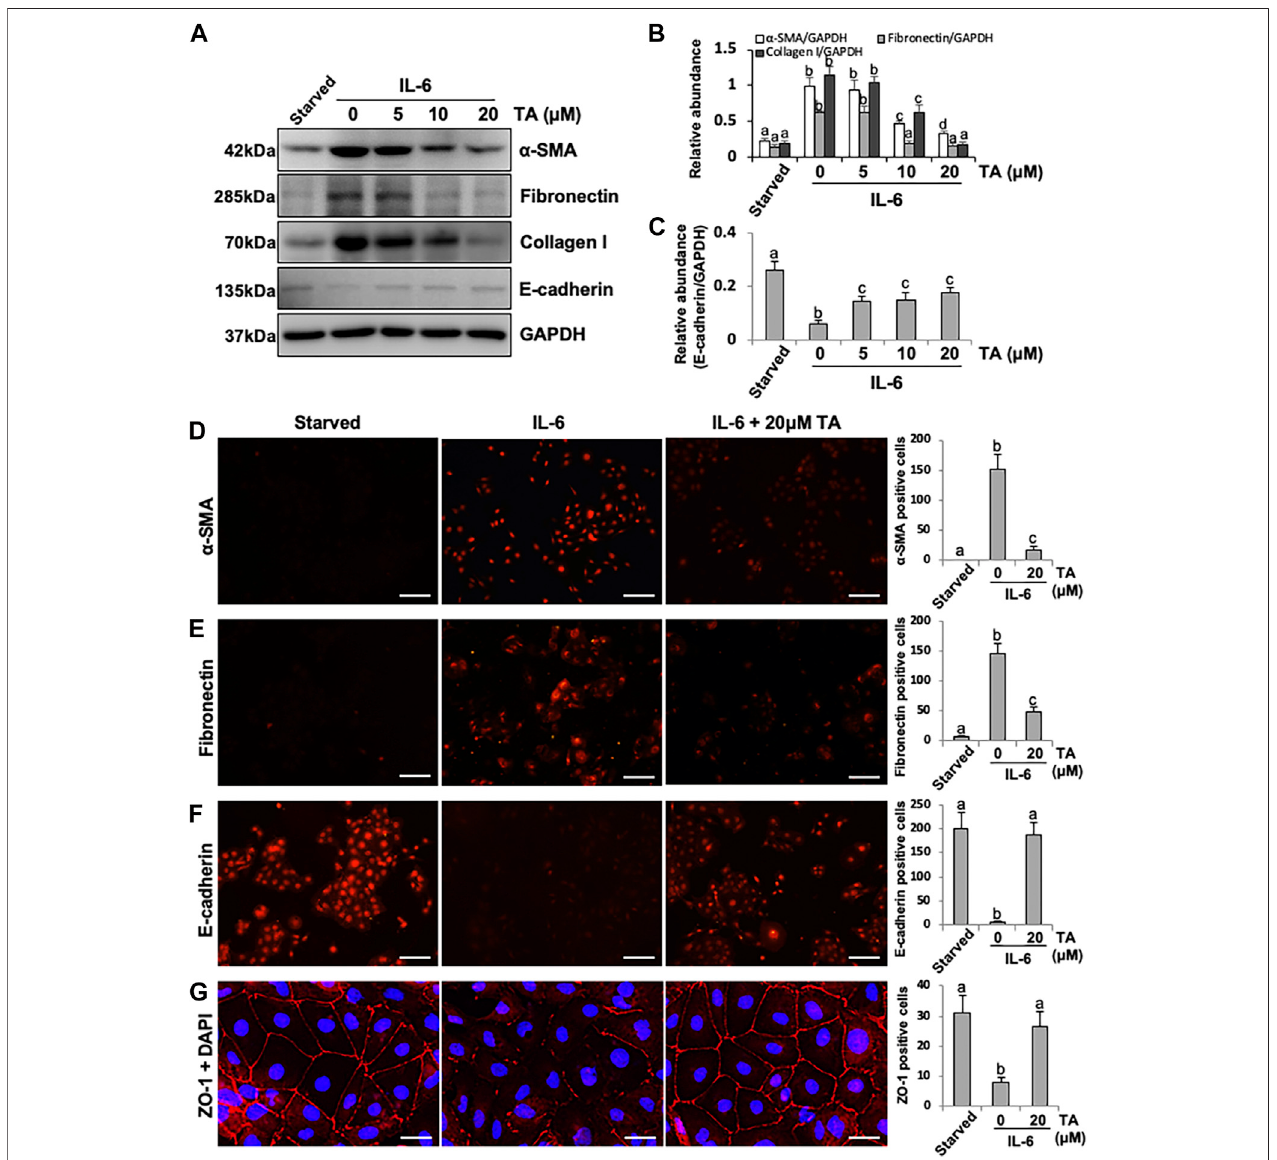
FIGURE 2 | Pharmacological blockade of HDAC6 inhibits IL-6-induced EMT of cultured human peritoneal mesothelial cells. (A) Cell lysates were subjected to immunoblotanalysiswithspeci fi cantibodiesagainst α -SMA,Fibronectin,CollagenI,E-cadherin,andGAPDH. (B) Expressionlevelsof α -SMA,Fibronectin,andCollagen I were quanti fi ed by densitometry and normalized with GAPDH. (C) Expression level of E-cadherin was quanti fi ed by densitometry and normalized with GAPDH. Immuno fl uorescence photomicrographs ( × 200) illustrate staining of α -SMA (D) , Fibronectin (E) , E-cadherin (F) , and ZO-1 (G) in HPMCs under different treatment. Thecountof α -SMA,Fibronectin,E-cadherin,andZO-1positivecellswascalculatedfrom10random fi eldsofeachcellsample.Dataarerepresentedasthemean ± SEM (n (cid:1) 3). Means with different superscript letters are signi fi cantly different from one another ( p < 0.05). The scale bars in D , E , and F (cid:1) 100 μ m and the scale bar in G (cid:1) 25 μ m.